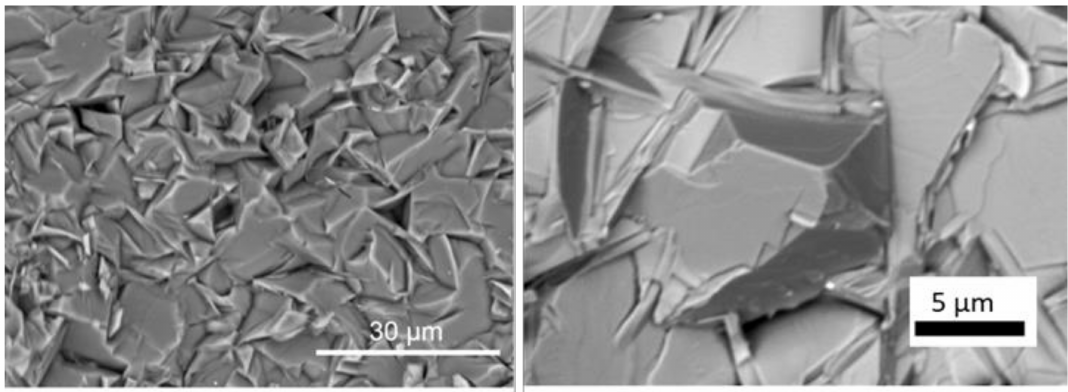
Figure 9. SEM images of the fractured surface of CAS GC